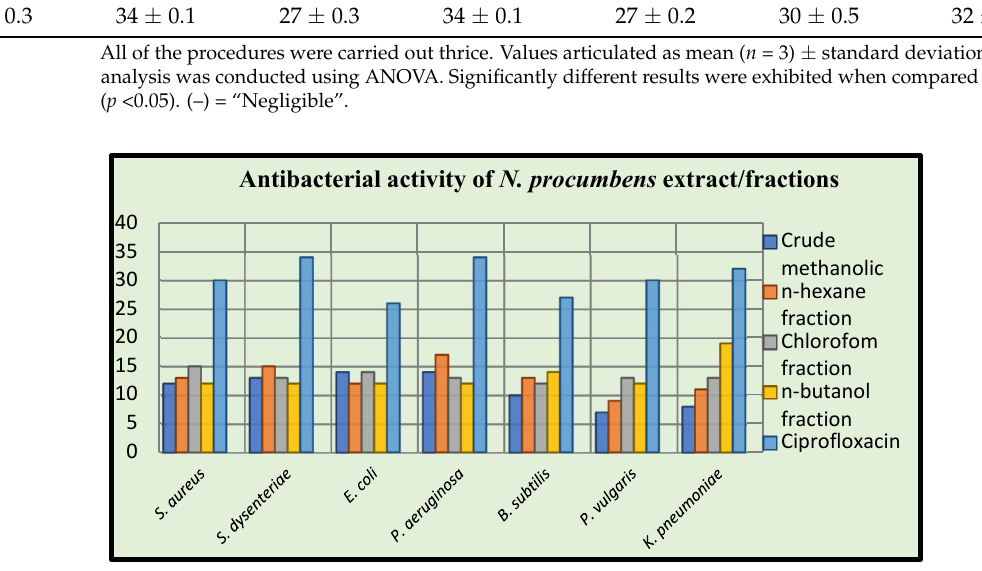
Table 6. Antibacterial activity of Neurada procumbens tested extract/fractions. Zone of Inhibition (mm) Mean ± SEM